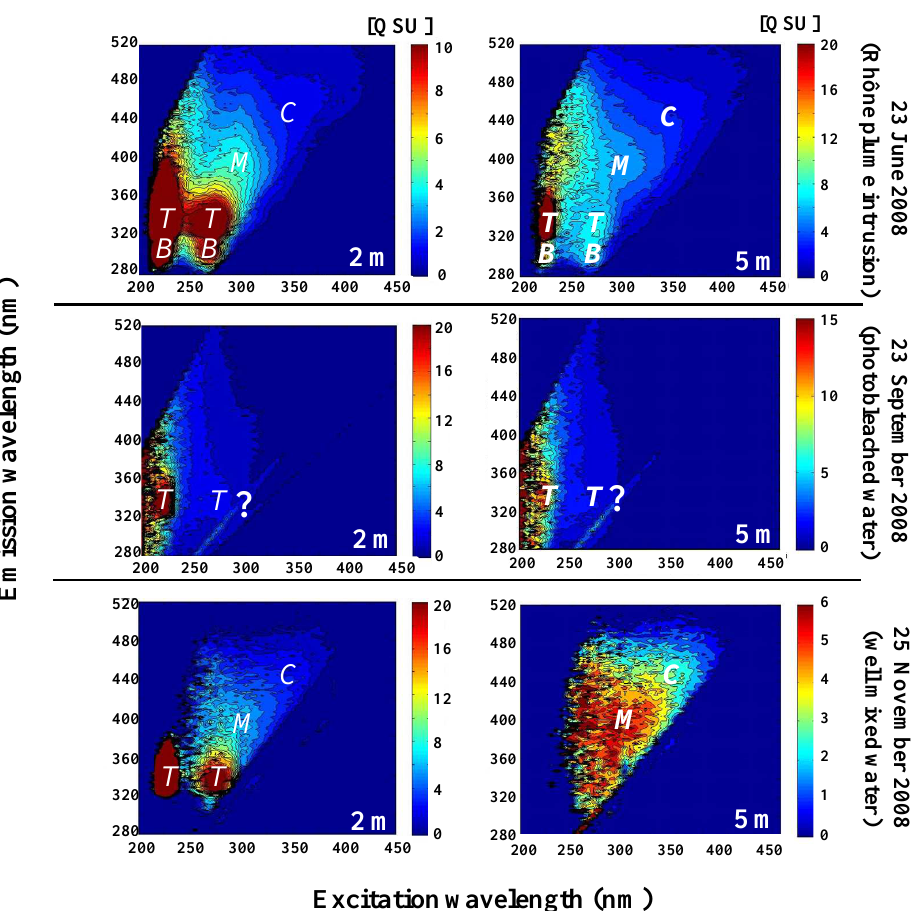
Fig. 4. 2-D EEM contour plots of CDOM (in QSU) collected in the Bay of Marseilles (SOFCOM station) at 2 (left panels) and 5m depths (right panels) on 23 June (upper panels), 23 September (middle panels) and 25 November 2008 (bottom panels). These spectra illustrated fluorescent peaks positions observed during this study. Corresponding peaks fluorescence intensities are reported on Table 2. On middle panels, question marks indicate a possible slight signature of the peak T. HIX and BIX values determined for marine (SOFCOM) and freshwater (Arles) samples are presented on Table